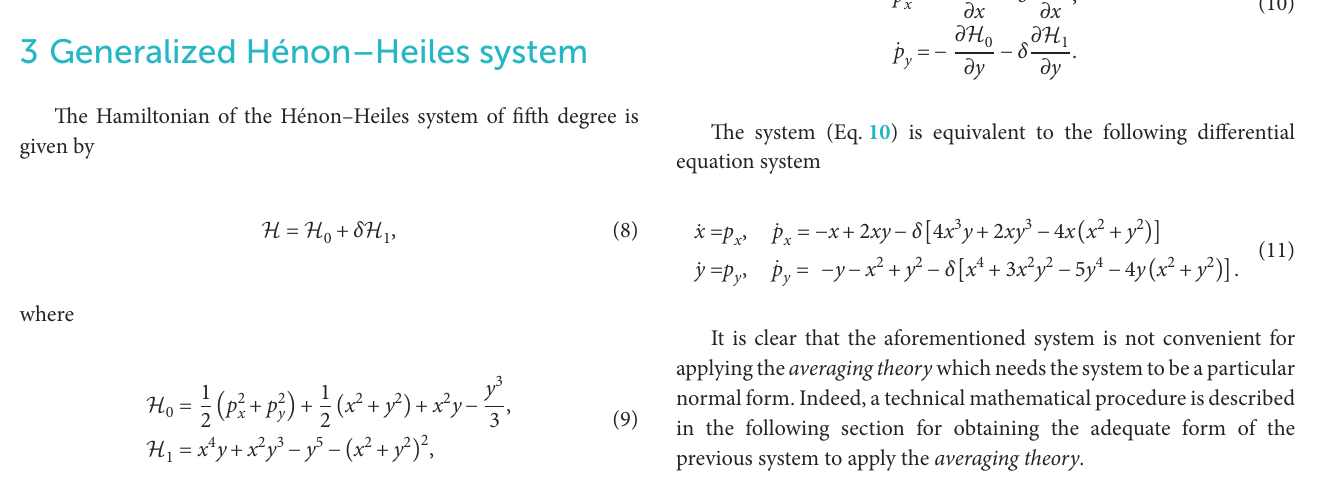
the escape energy must be equal to or greater than the minimum value of critical energy ( E ≥ E ) . Thus, we conclude that the value of esc min the parameter δ increases while the energy of escape decreases; this property is shown graphically in Figure 5 ; see also for details (Antipov and Nagaitsev, 2017; Dubeibe et al.,